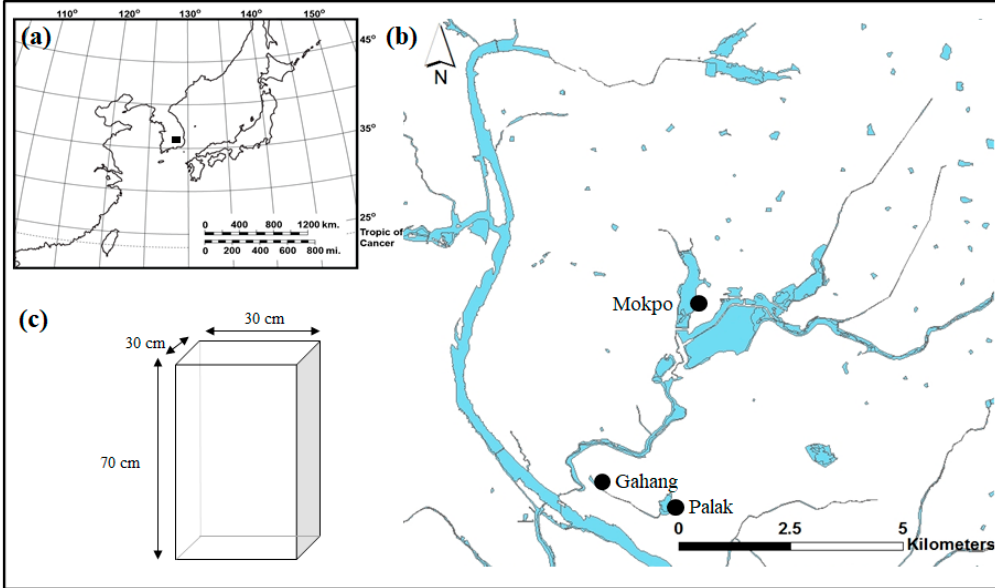
Figure 1. Map of the study sites. The sites located in southeastern South Korea are indicated by solid squares ( ■ ). ( a ) The Korean Peninsula, ( b ) the study sites (Mokpo, Gahang, and Palak Wetlands), and ( c ) water sampler design (water column of 20-L and size 20 × 30 × 70 cm). The sampling locations are identified as solid circles ( ● ). The wetlands have shallow depths and are covered by various aquatic plant species.